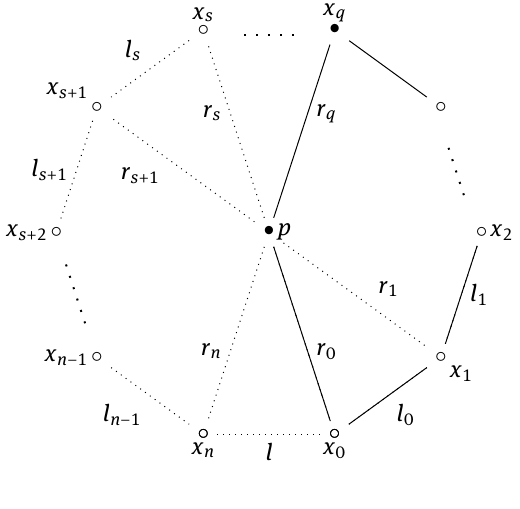
Figure 2: The constructed 3